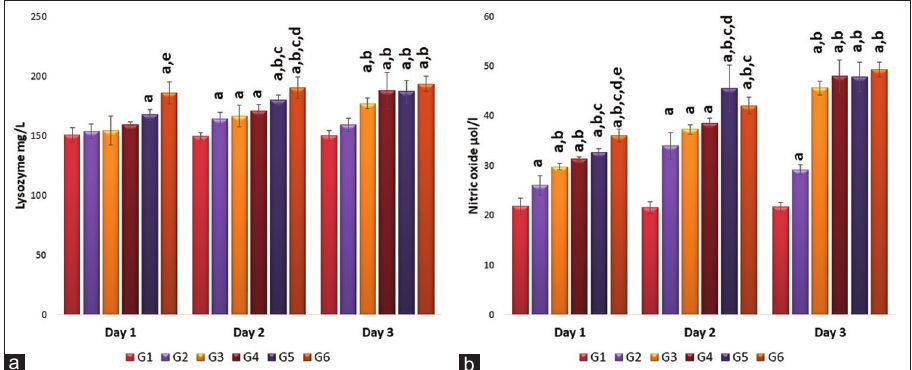
Figure-3: (a and b) Effect of single and repeated intravenous injection of 300 μ g/kg body weight 50 nm either gold nanosphere or gold nanorods in male rabbits on lysozyme and nitric oxide on days 1, 2, and 3 post-treatment. Means carrying superscripts are significantly different at p<0.05 based on Tukey’s honestly significant difference. a=Significantly different versus G1, b=Significantly different versus G2, c=Significantly different versus G3, d=Significantly different versus G4, and e=Significantly different versus G5.